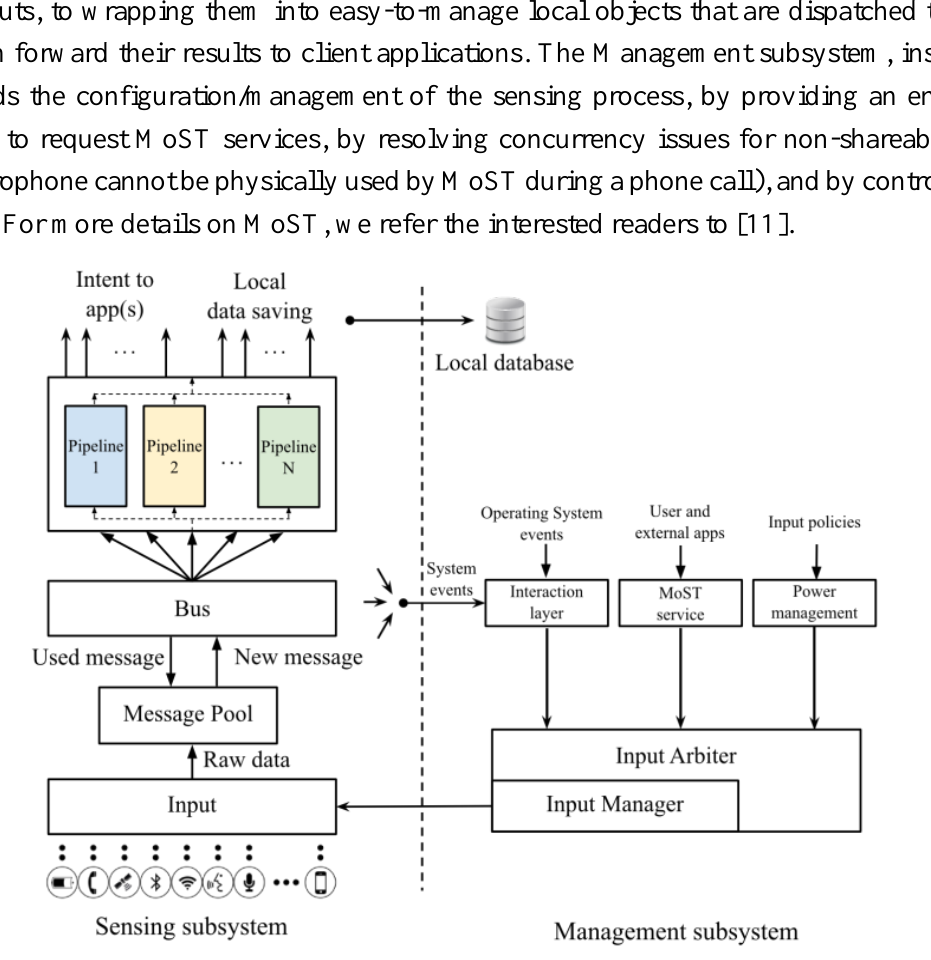
Figure 3. The MoST